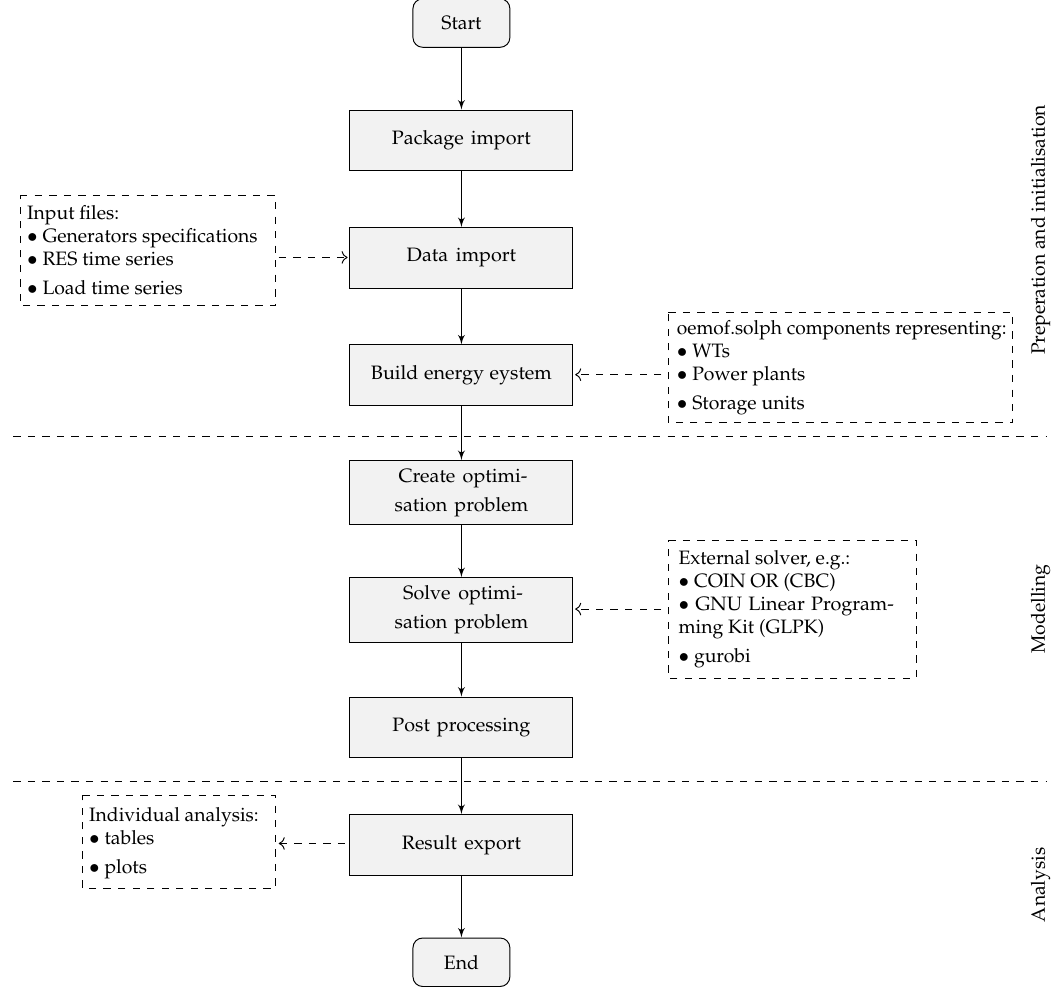
Figure 1. Schematic overview of the full modelling process applying OpInMod. In the preperation and initialisation part of the process, necessary data is imported and the energy system is created using oemof.solph’s base components. The base components are extended by attributes and functions to depict synchronous and SI. In the modelling part of the process the optimisation problem, including OpInMod’s inertia constraints, is created, solved by an external solver and the results are processed and prepared for the output. In the last section of the process, results are exported and can be further analysed as needed.